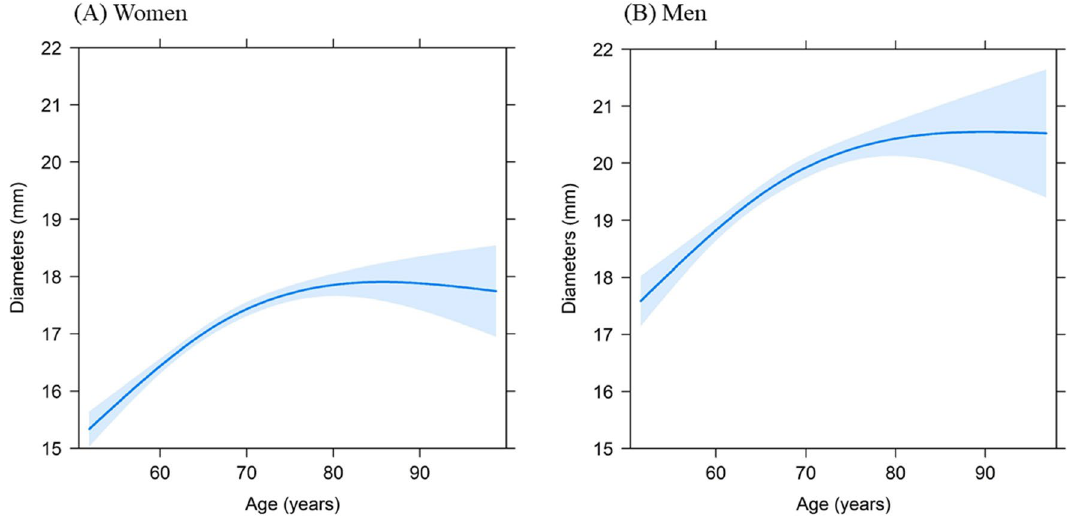
Figure 1. Effect plot for the association between infrarenal aortic diameters and age among women and men. Blue shaded areas represent 95% confident